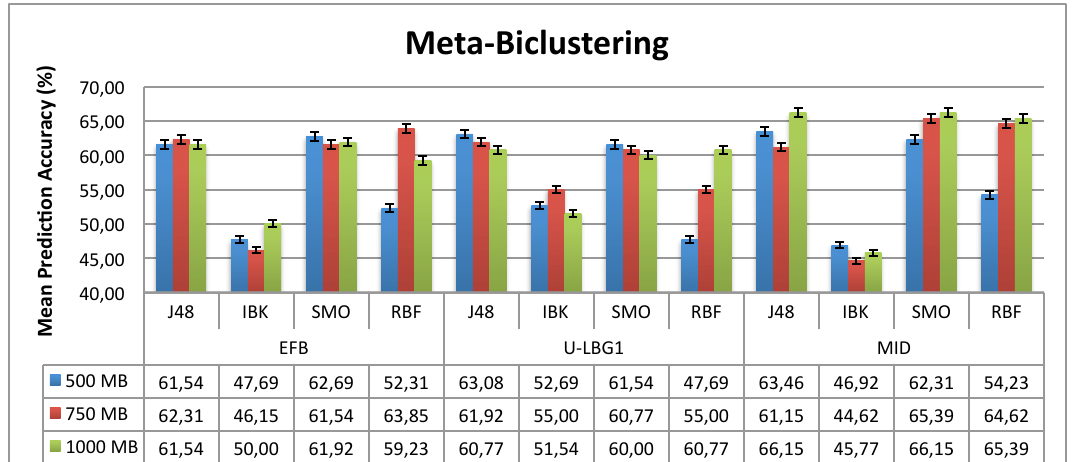
Figure 5: Mean prediction accuracy and standard deviation resulting from Meta-Biclustering with the discretization techniques EFB, U-LBG1 (unsupervised) and MID (supervised), using q = 2 bits. 500, 750 and 1000 meta-biclusters (MB) were considered. Classification is performed by the following Weka classifiers: J48 (Decision Tree), IBK (k-Nearest Neighbors), SMO (Support Vector Machine), and RBF (Radial Basis Function Network). The 5 x 4-fold CV evaluation , with the same partitions as in [7], is